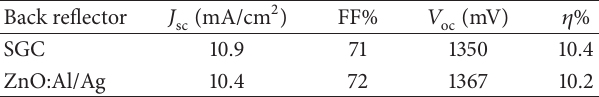
Figure 3: The total internal quantum efficiency (IQE) of tandem thin-film silicon solar cells with ZnO:Al/Ag back reflector (black dash line) and SGC back reflector (red line). Table 1: Light 𝐼 - 𝑉 characteristics of a-Si:H/ 𝜇 c-Si:H tandem solar cells with ZnO:Al/Ag back reflector and SGC back